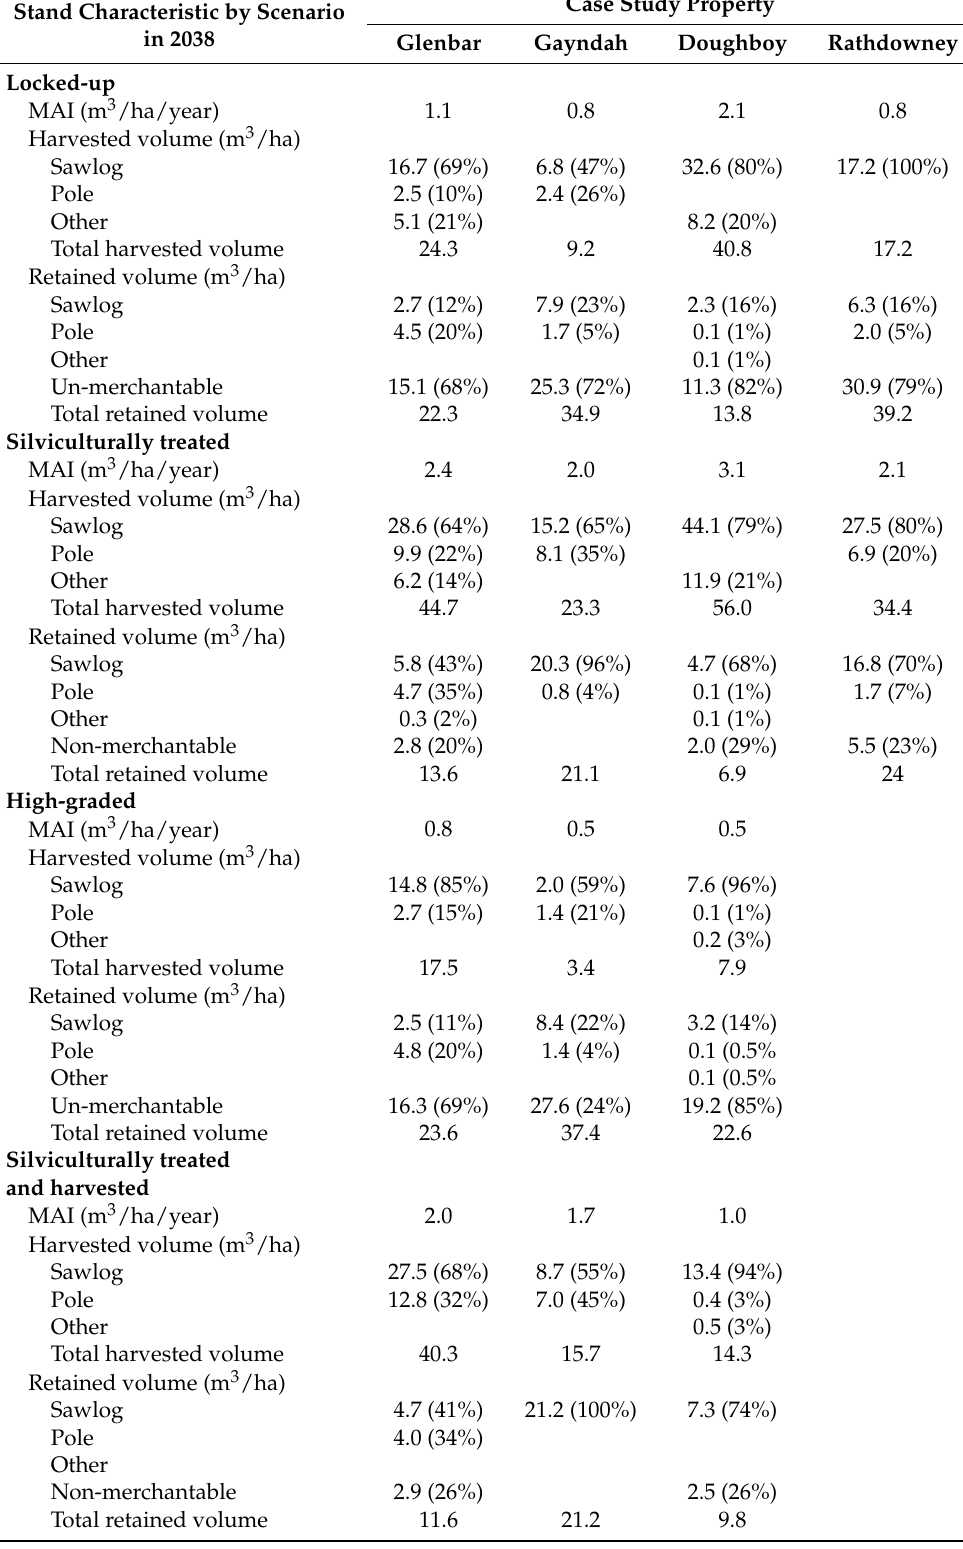
Table 4. Mean annual increment and product volumes in